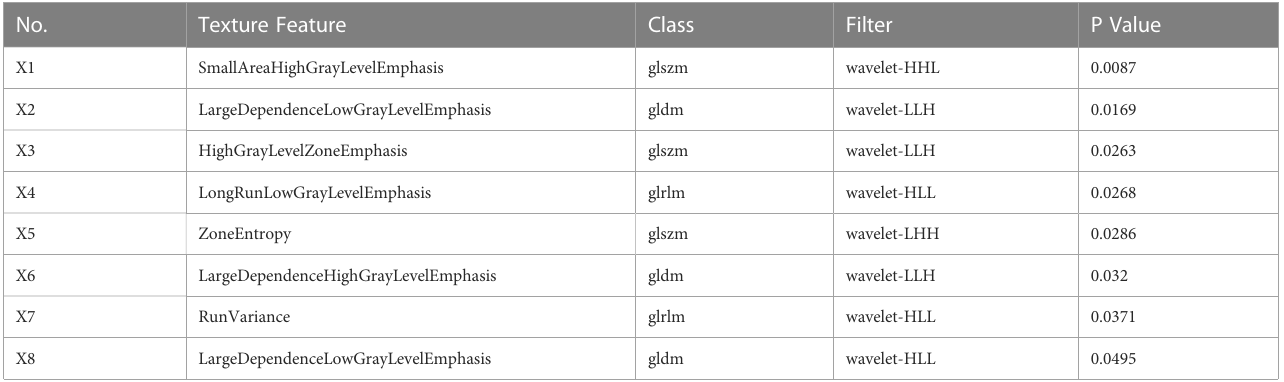
TABLE 5 Optimal texture features from the delayed phase. No.